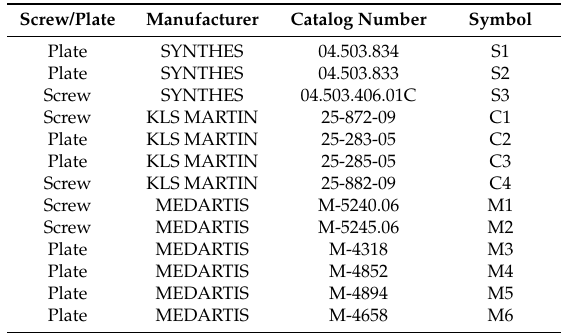
Table 2. 3D Titanium condylar plates and dedicated